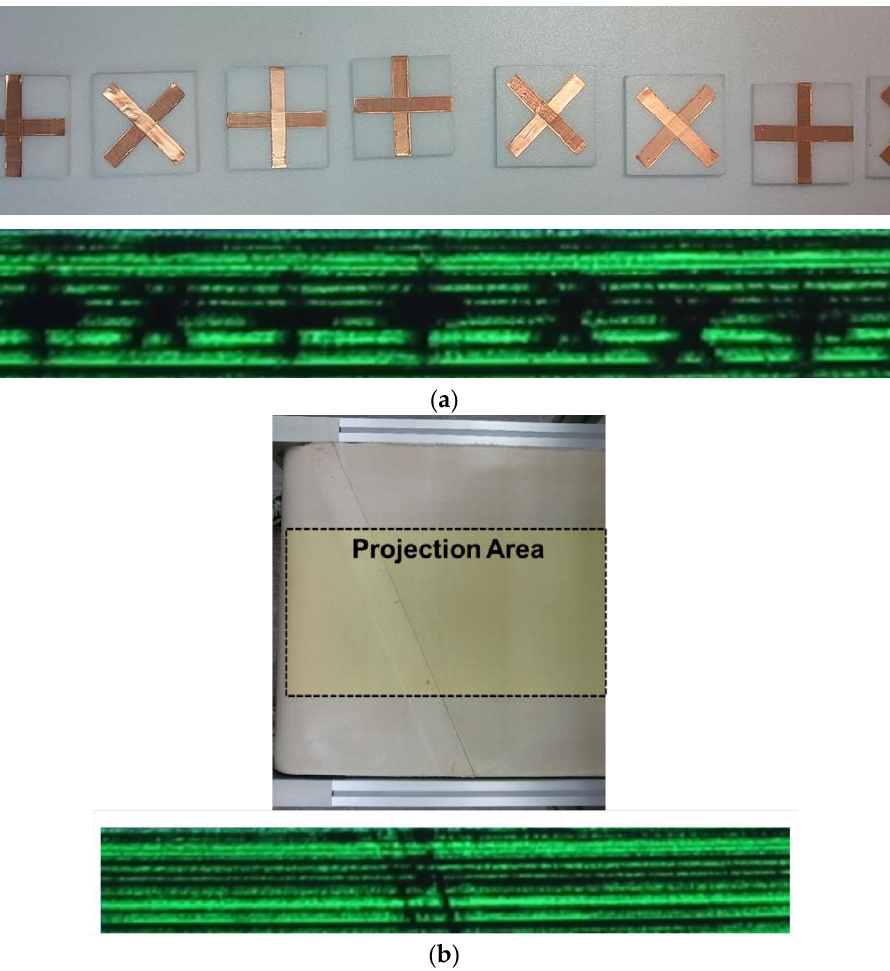
Figure 11. Photographs of samples and captured images of real-time THz videos of moving samples ( a ) two types of patterns of “+” and “−“ and ( b ) adhesive tapes with an acetate to bond the conveyor belt.